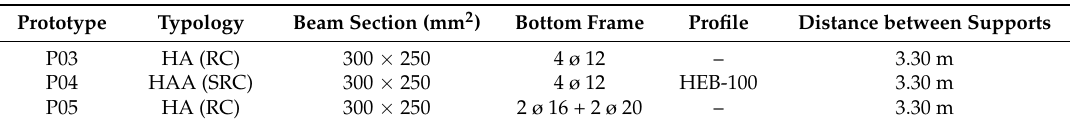
Table 1. Summary of the tests carried out. RC, reinforced concrete; SRC, steel reinforced concrete in columns and beams.